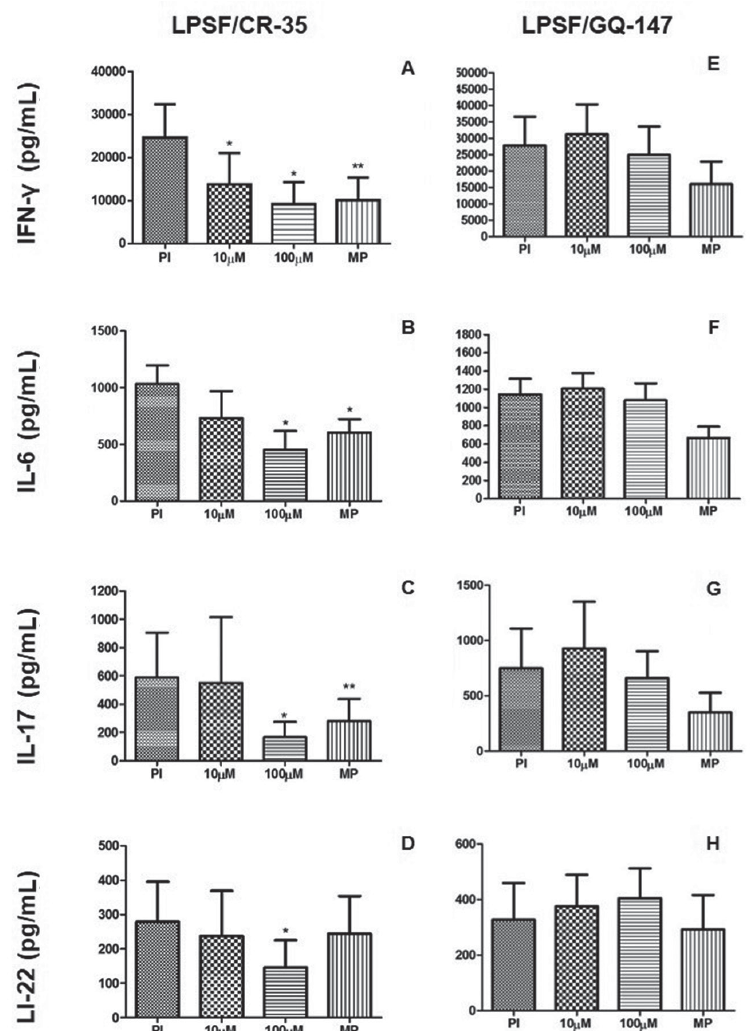
FIGURE 3 - Evaluation of pro-inflammatory cytokines release inhibition by LPSF/GQ-147 in PBMC culture from children asthmatic patients. IFNγ (A, B); IL-6 (C, D); IL-17A (E, F); IL-22 (G, H). PI = PMA + Ionomycin; MP = methylprednisolone. (*p<0.05 and